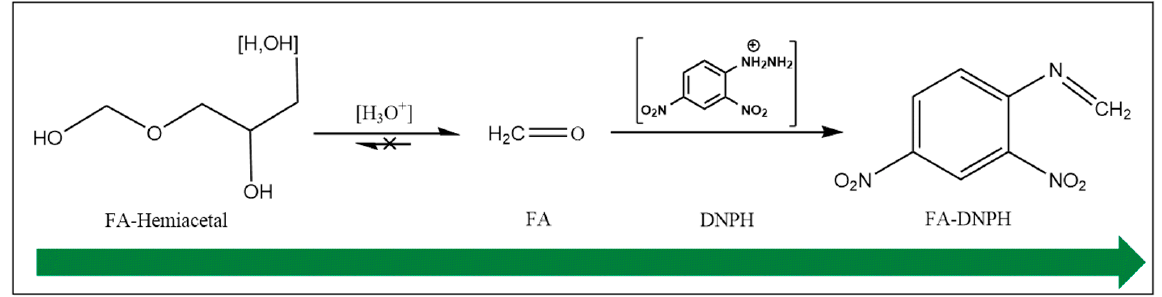
Figure 8. Concurring chain reactions between participating reactants in H+/DNPH environment.